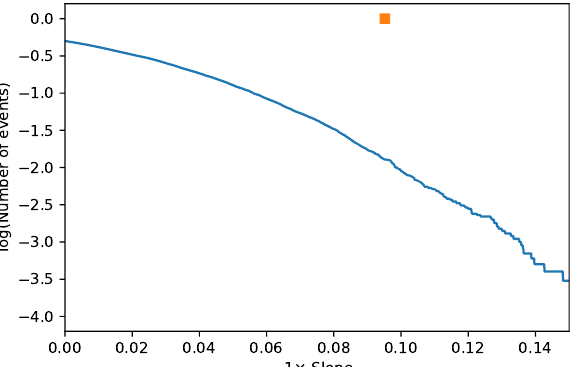
log ( p -value )) 0.5 < 2.5. We see −